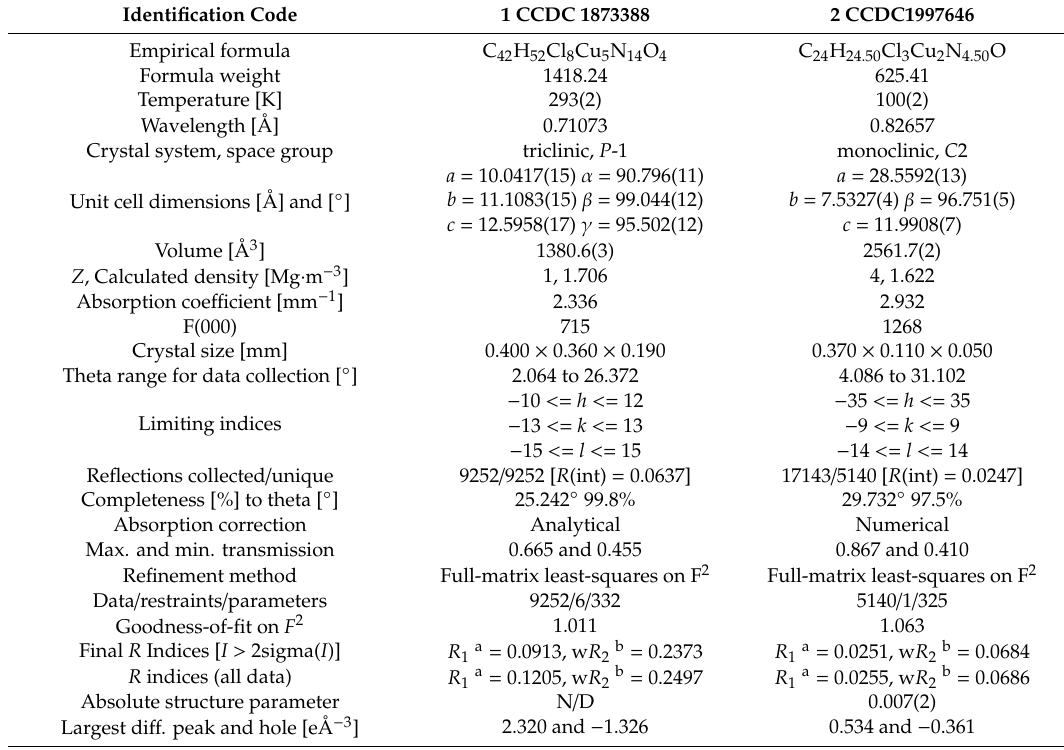
Table 2. Crystal data and structure refinement for 1 and 2 .